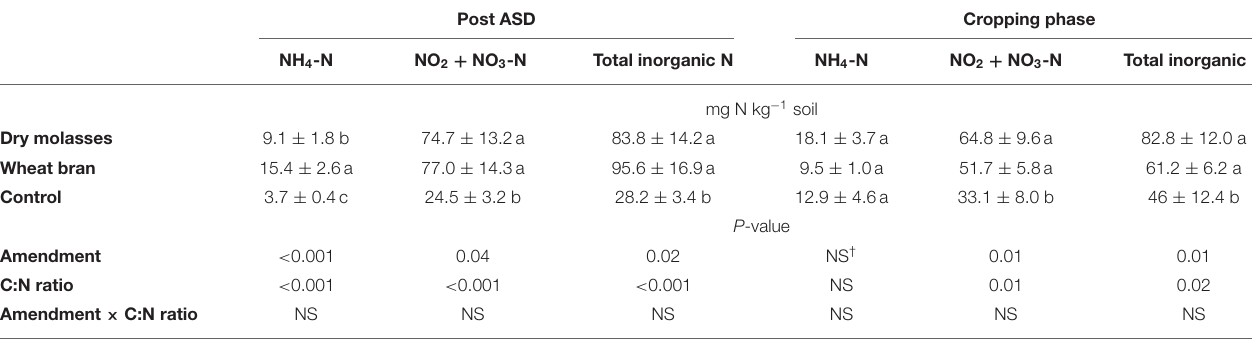
TABLE 2 | Main effect of ASD amendment and analysis of variance for soil nitrogen response variables after ASD and/or during cropping phase as affected by soil treatment in trial 1. Post